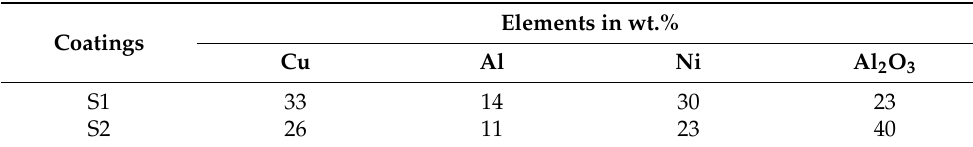
Table 1. Elemental compositions of the coating feedstock powders.